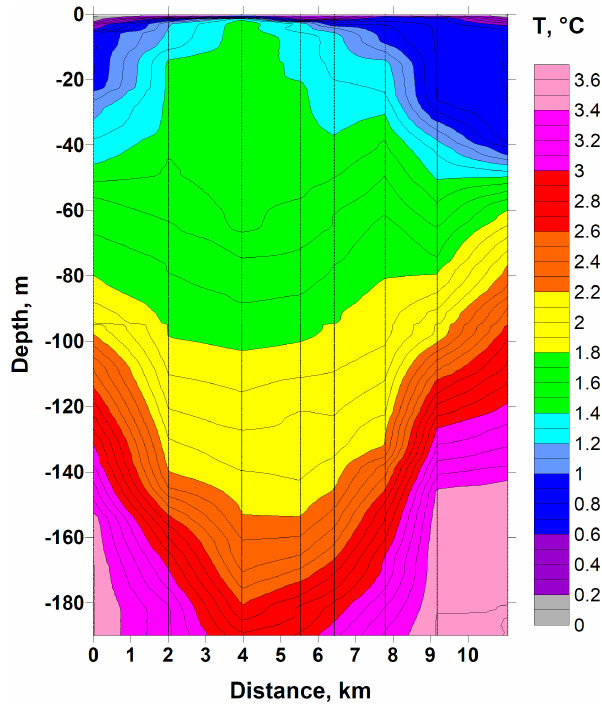
Figure 1. Vertical section of water temperature ( ◦ C) below the ice, 28–30 March 2018, across the eddy in the region of Cape Nizhneye Izgolovye (Middle Baikal). X axis – distance along the transect. Eddy centre is located approximately at a 4–5km position. Vertical lines – station positions. This eddy led to the formation of a giant ice ring in late April 2018 (http://icerings.org/news_en.htm, last access: 20 September